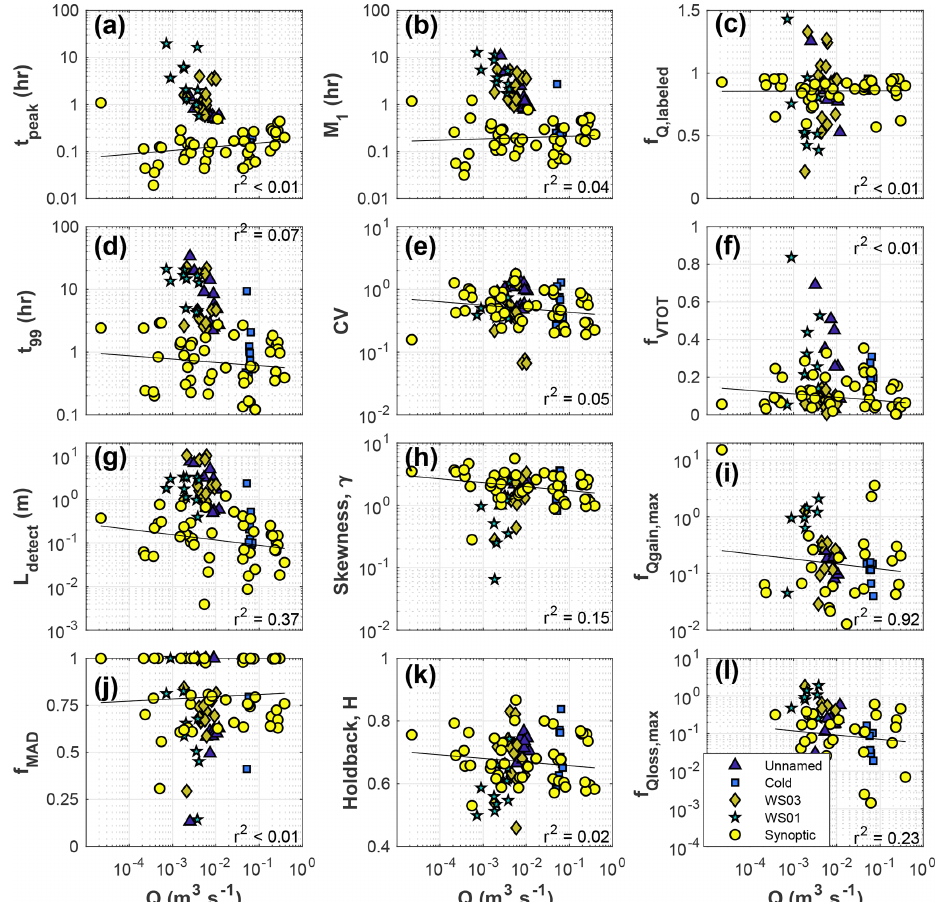
Figure 4. Fixed-reach and synoptic data as a function of stream discharge. Statistical likelihood of significant relationships (Mann–Kendall test) and their direction (Sen’s slope) are detailed for all sub-reaches and the synoptic data in Table 3. All trends shown here are significant (MK test, p< 0 . 05). The coefficients of determination for power-law best fits to synoptic data (black lines) are reported in Table 3. Data from unnamed creek (triangles, Cold creek (squares), WS03 (diamonds), and WS01 (stars) show the repeated injections through baseflow recession of each headwater catchment. See Supplement Figs. S5 and S6 for similar plots with HYP POT and UAA on the x